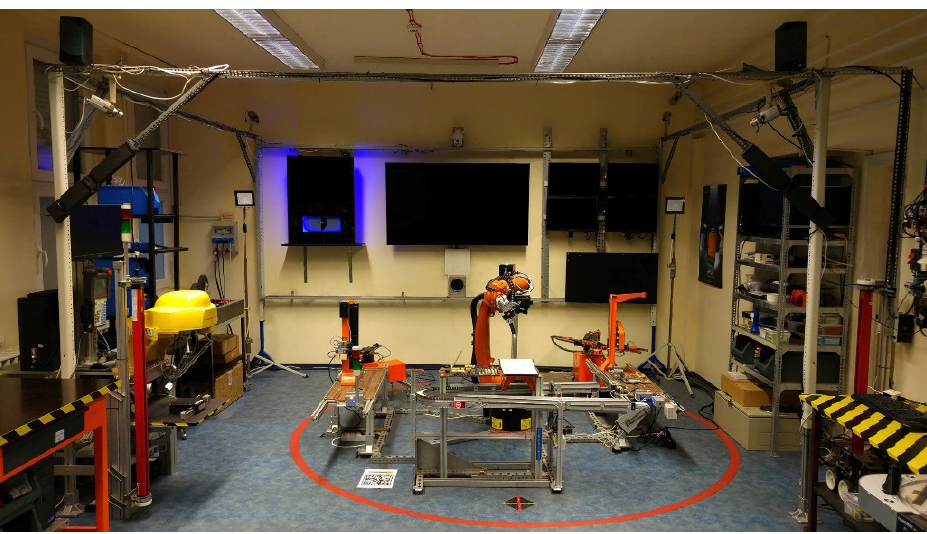
Figure 1. The cyber-physical and intelligent robot systems laboratory.